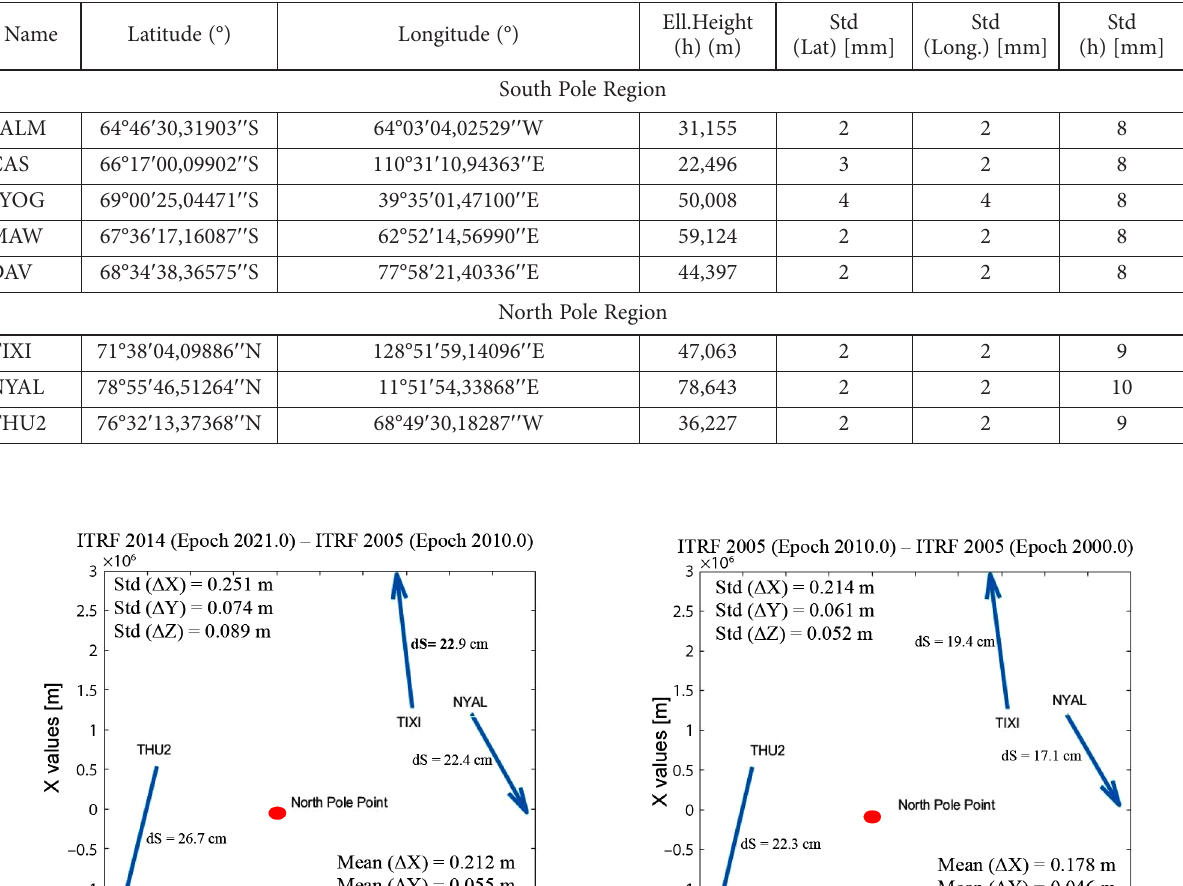
Table 3. Standard deviation and coordinate values (ITRF 05, Epoch 2010.0) of the eight IGS points by processing static GNSS satellites (CSRS-PPP Software) on the South and North Pole Region ITRF 2014 (Epoch 2021.0)